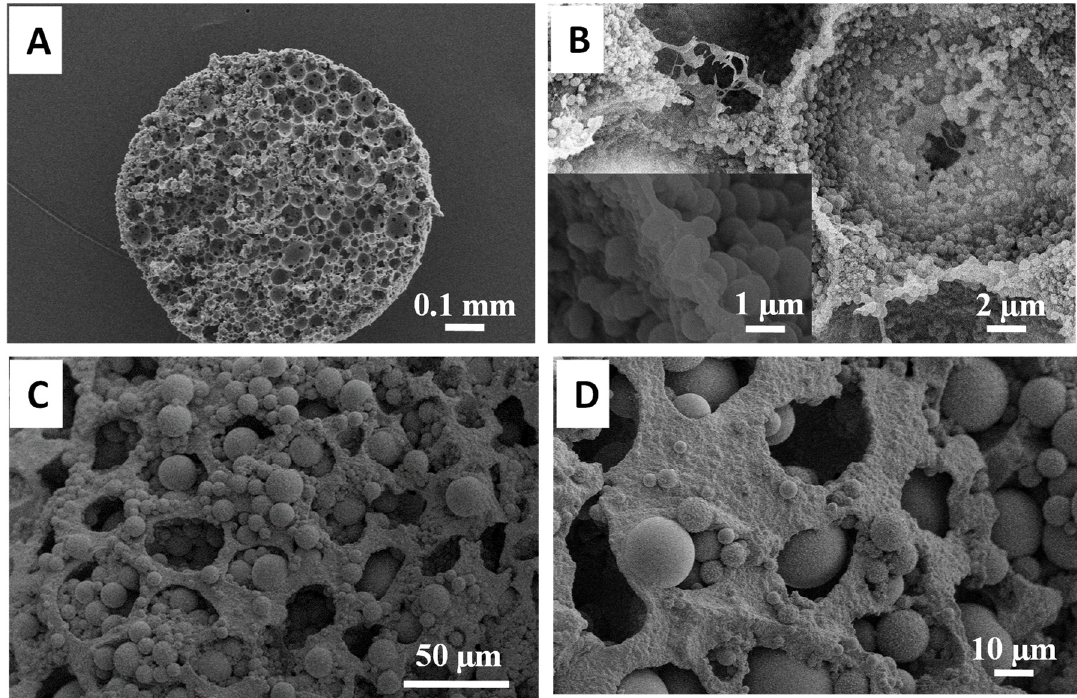
Figure 1. Silica microspheres were synthesised inside PAM beads using ( A , B ) 2.5 cm 3 of TEOS and ( C , D ) 2.5 cm 3 of MPTMS in the reaction. Cross-sectioned surface of the as-prepared ( A , B ) TEOS–PAM bead with the inset of B showing the silica spheres on the pore surface. ( C ) The cross-sectioned surface of the MPTMS–PAM bead. ( D ) Exterior surface of the MPTMS–PAM bead. Both ( C ) and ( D ) show a distribution of large silica microspheres trapped within the macropores.